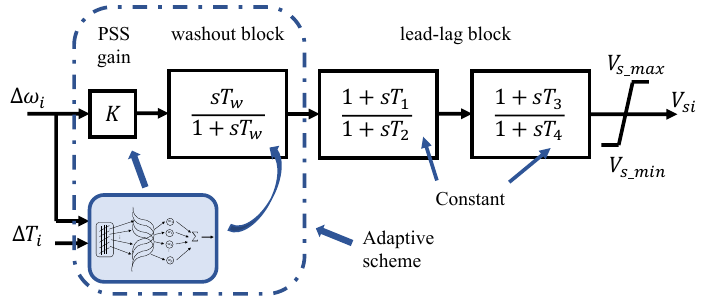
Figure 1. Improved power system stabilizers with adaptive scheme.